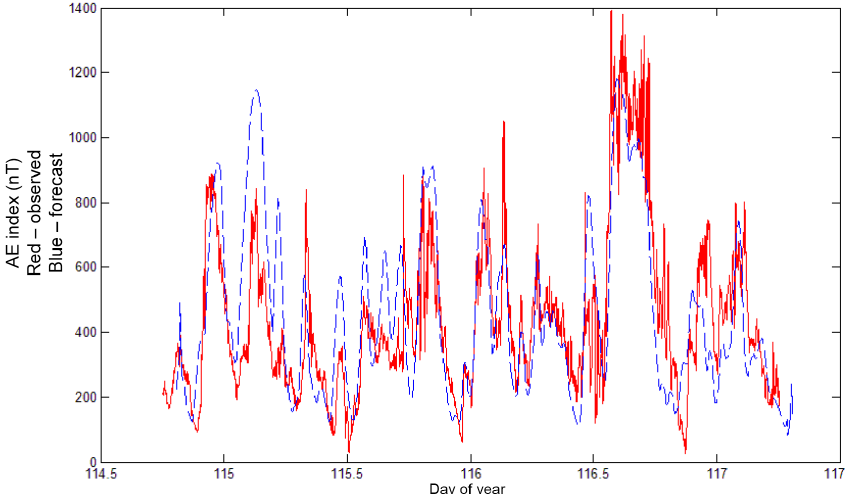
Figure 3. Comparison between the calculated AE ∗ (dashed blue line) and the real AE index (solid red line) for event 1_1998.